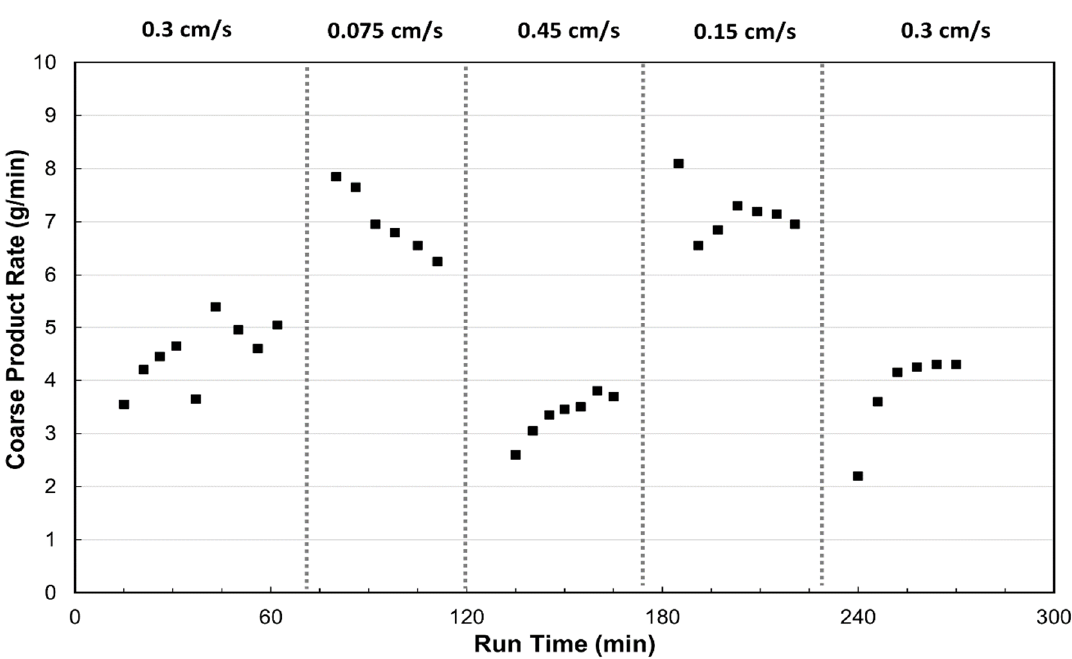
Figure 5. Measured coarse (+0.355 mm) product rate as a function of experiment run time. Dotted vertical lines indicate a change in the supplied gas rate, with the gas rate during each interval listed above.